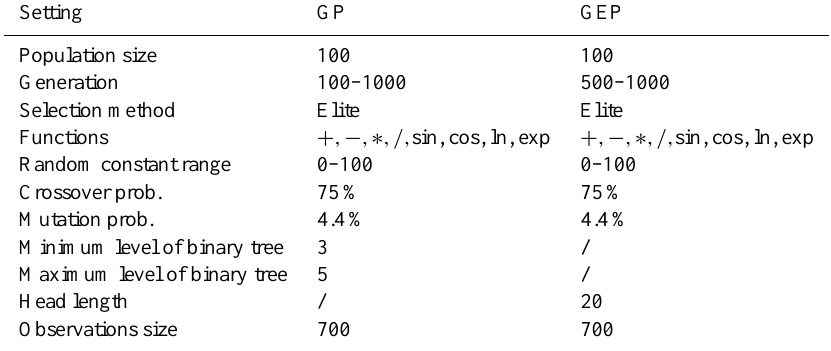
Table 1. Parameters in the EM procedure.